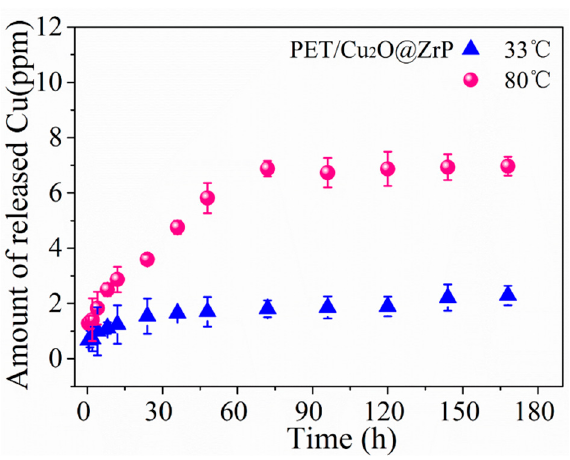
Figure 8. Cu release curves of PET/Cu 2 O@ZrP hybrid fibers on a daily basis in 200 mL ultrapure water at 33 °C and 80 °C.